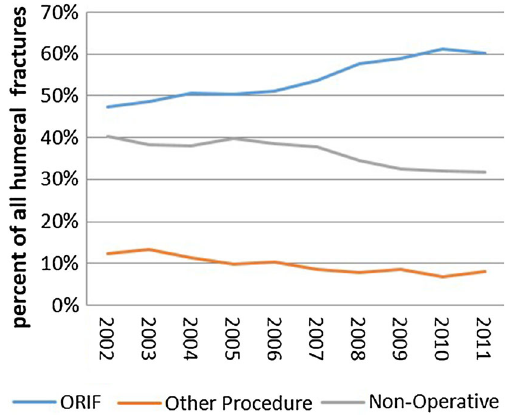
Fig. 1 Annual trend of utilization of all treatment modalities for humeral shaft